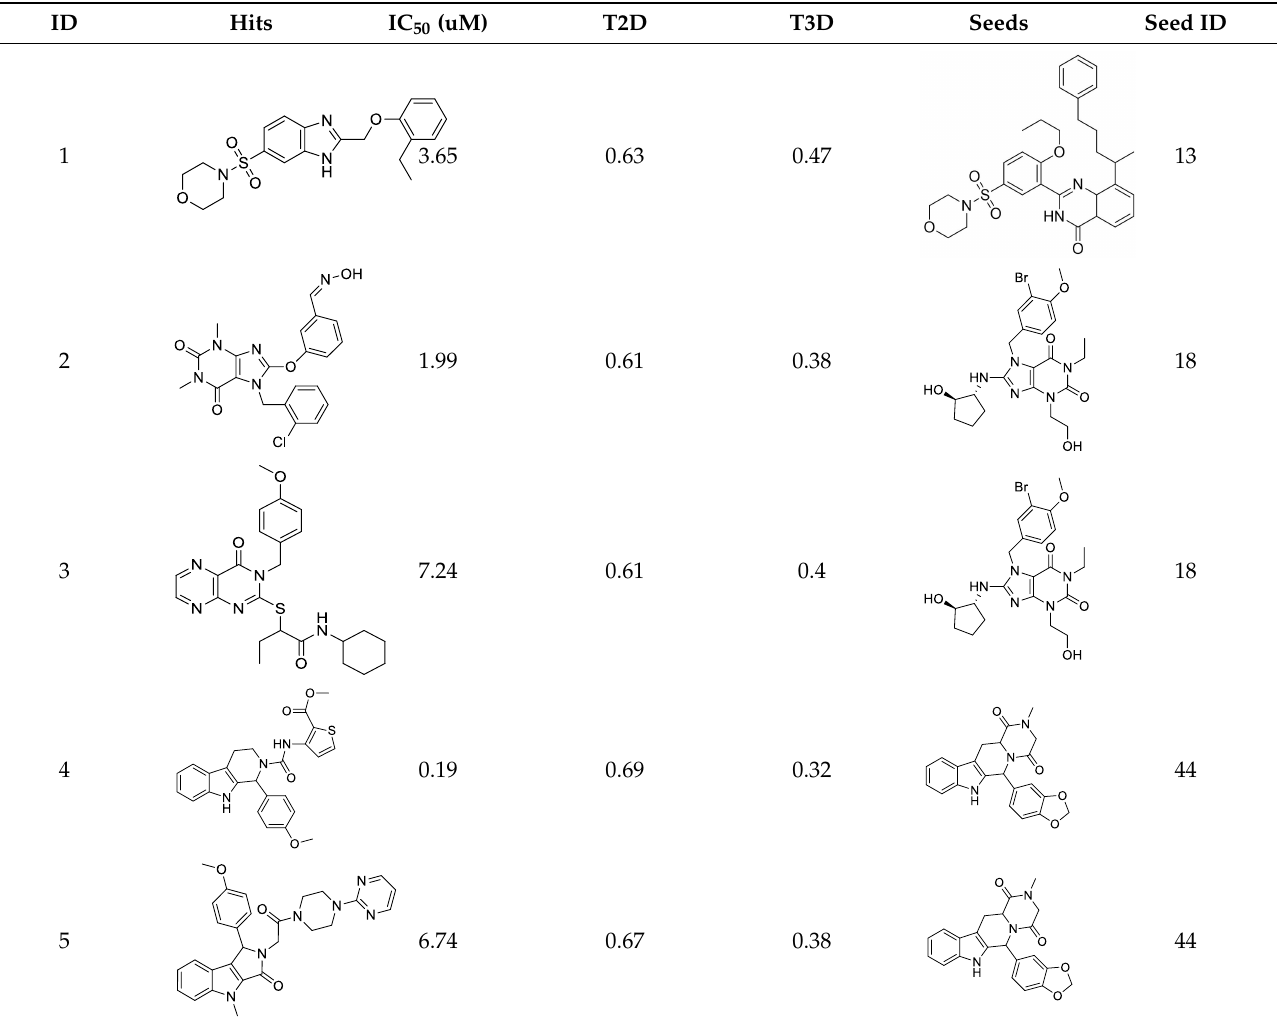
Table 5. The calculated T2D/T3D values of the 5 PDE5 inhibitor hit